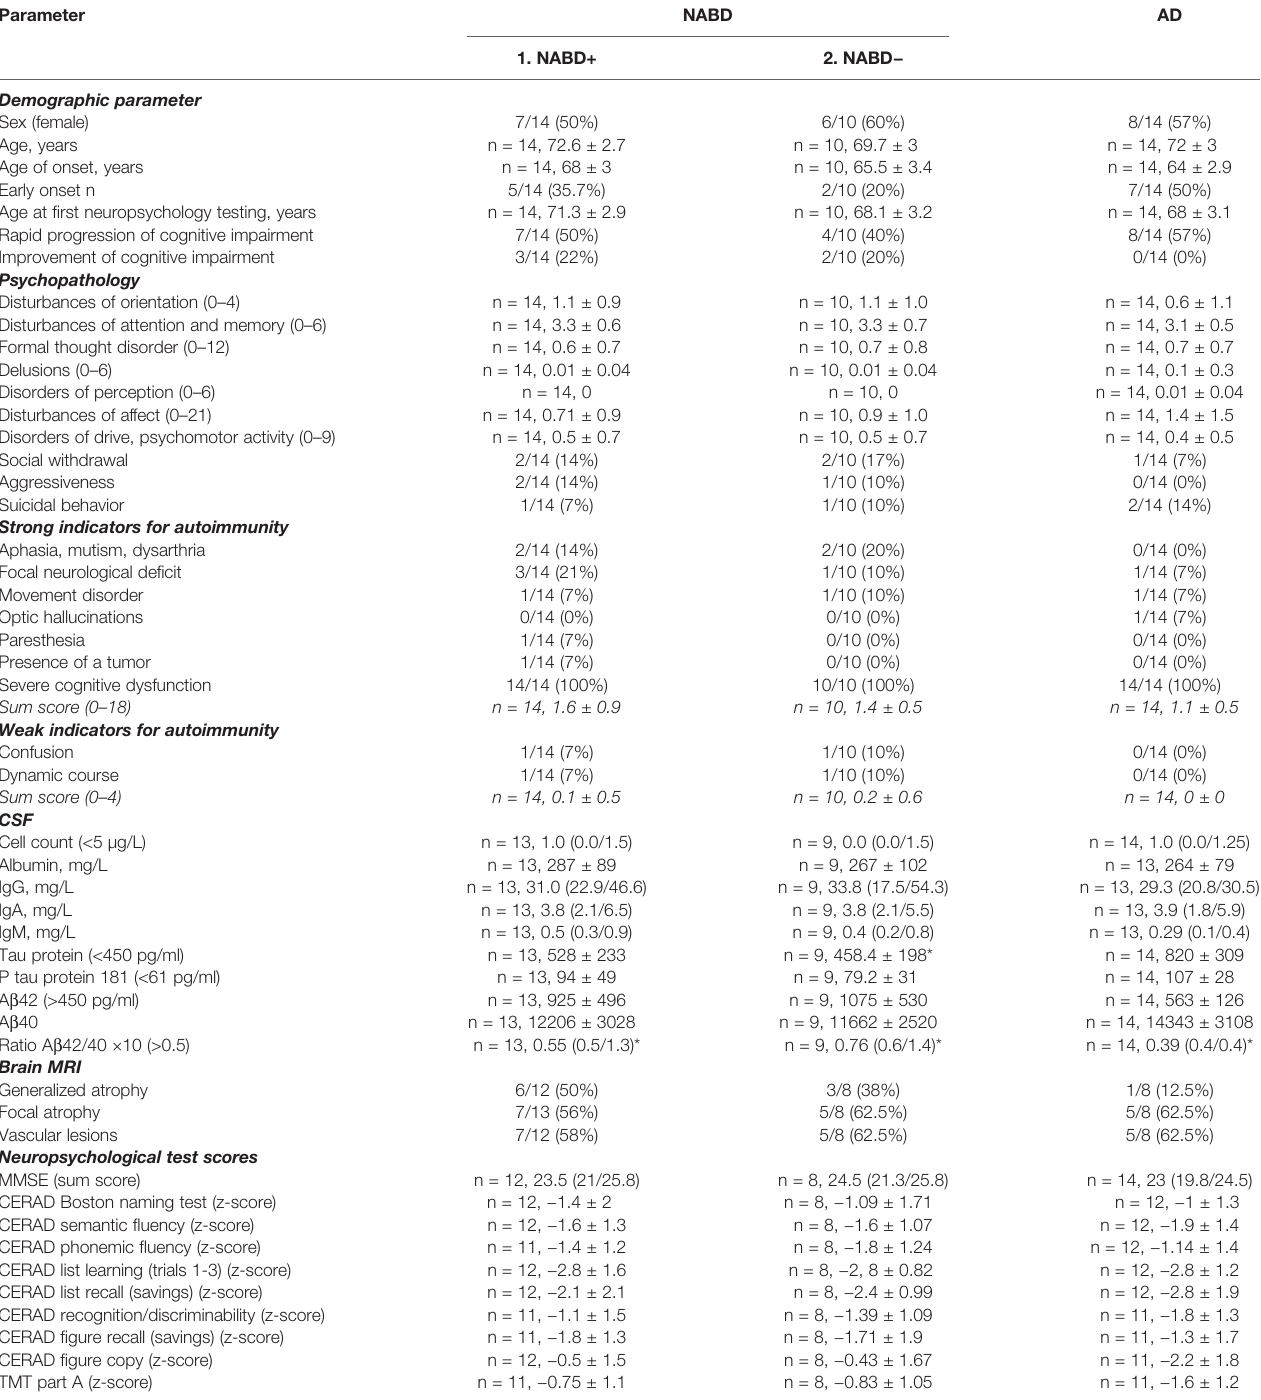
TABLE 1 | Clinical characterization of patient